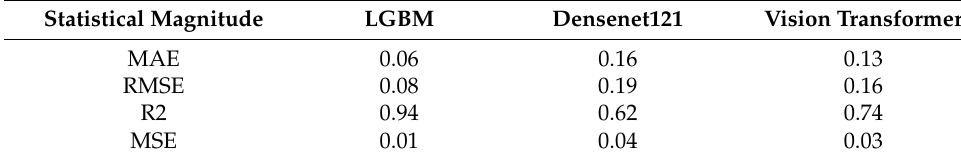
Table 2. Statistical magnitude of true and predicted values in the validation